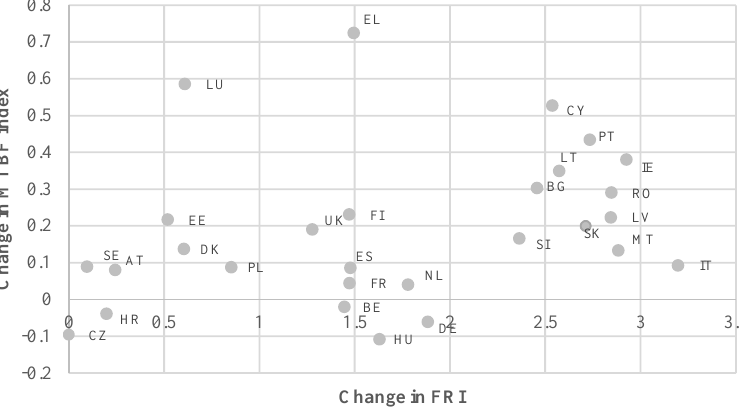
Source: own calculations based on the European Commission data (MTBF database and fiscal rules database – “new”